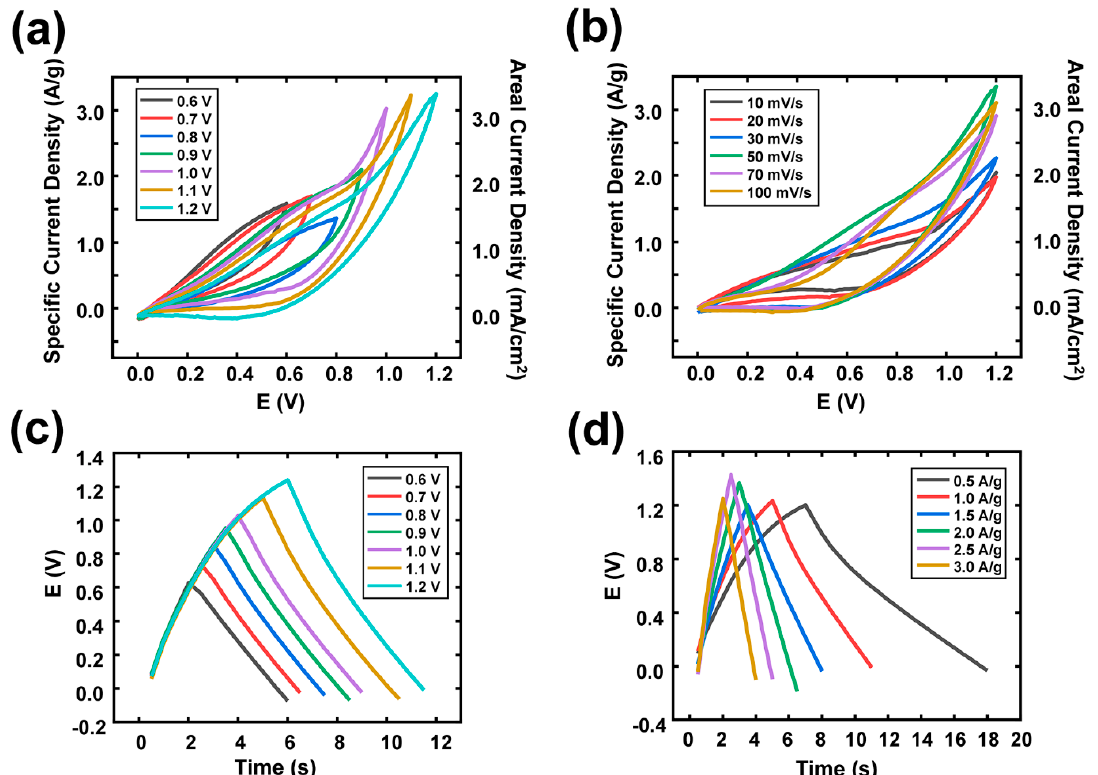
Figure 4. The electrochemical tests of the full device with the DE from the two-electrode system: The CV plots ( a ) under various potential windows and ( b ) under various scanning rates. The GCD curves plots ( c ) under various potential windows and ( d ) under different applied current densities.